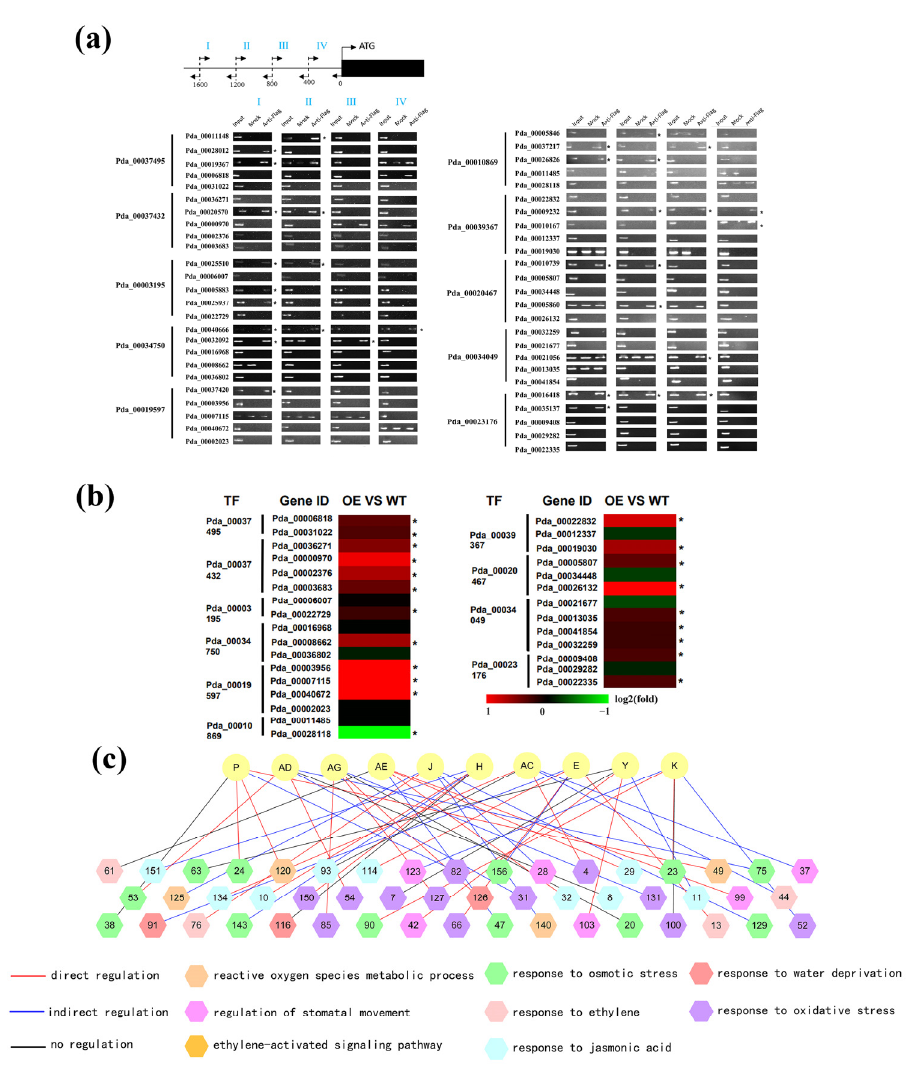
Figure 3. Verification of the regulatory relationship between the second and third layers in the GRN. ( a ) Verification of the regulatory relationships between the second and third layers using ChIP-PCR. The promoters ( − 2000 to 0 bp) were divided into four equal-length fragments (I to IV) for ChIP- PCR. Input, mock, and anti-FLAG indicate the chromatin before immunoprecipitation (IP), IP with no antibody (mock), and IP using anti-FLAG antibodies (anti-FLAG), respectively. An asterisk (*) indicates the binding of a TF to the truncated promoters. ( b ) Verification of the indirect regulatory relationship between the second and third layers using qRT-PCR. The heatmap represents the relative expression (fold change) of the genes in poplar plants overexpressing each TF relative to the control (transformed with empty vector). Red indicates up-regulation; green indicates down-regulation. An asterisk (*) indicates significant gene expression regulation ( p < 0.05). ( c ) A summary of the regulatory relationship between the second and third layers in the GRN. The gene names are shown in Table S5.